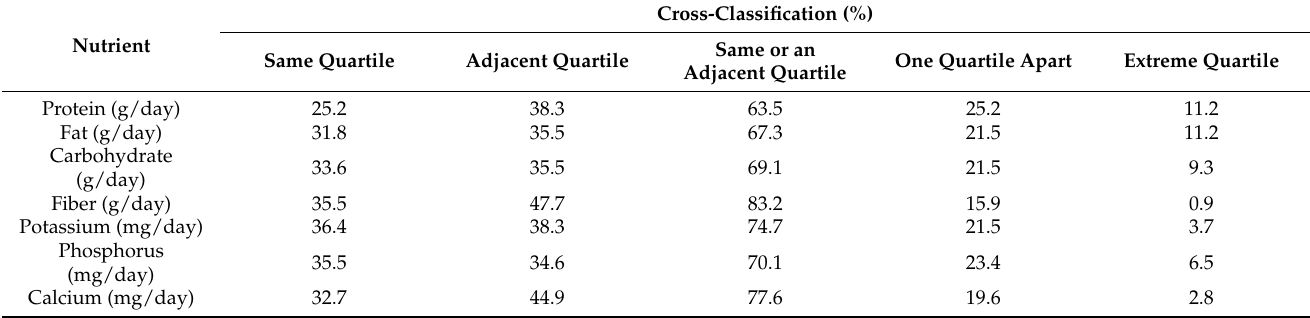
Table 3. Cross-classification of short food frequency questionnaire- (FFQ-) and 3-day dietary recall- (3-day DR-) derived daily macronutrient intakes after adjusting for energy intake in 107 CKD